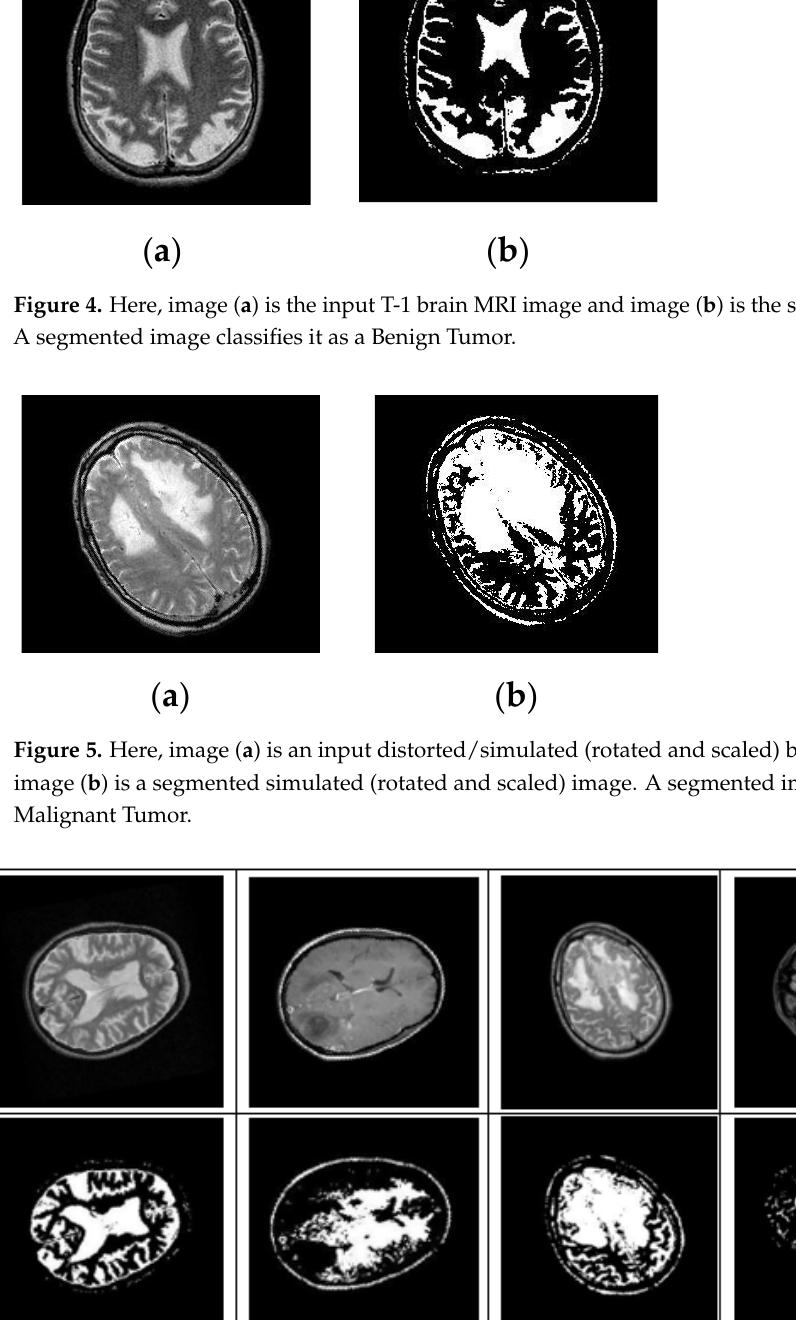
Figure 6. Rotation Invariant ( − 180° to +180°) Brain MRI Image Detected by CNN.